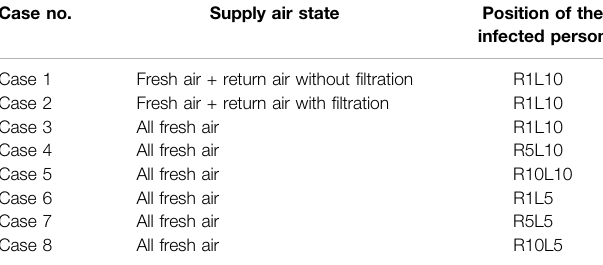
TABLE 1 | Parameters of each working condition. Case